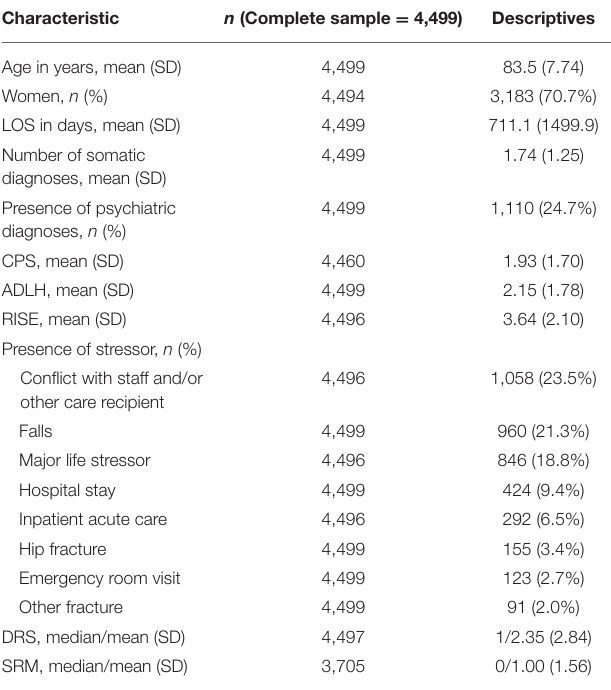
TABLE 2 | Description of the complete study